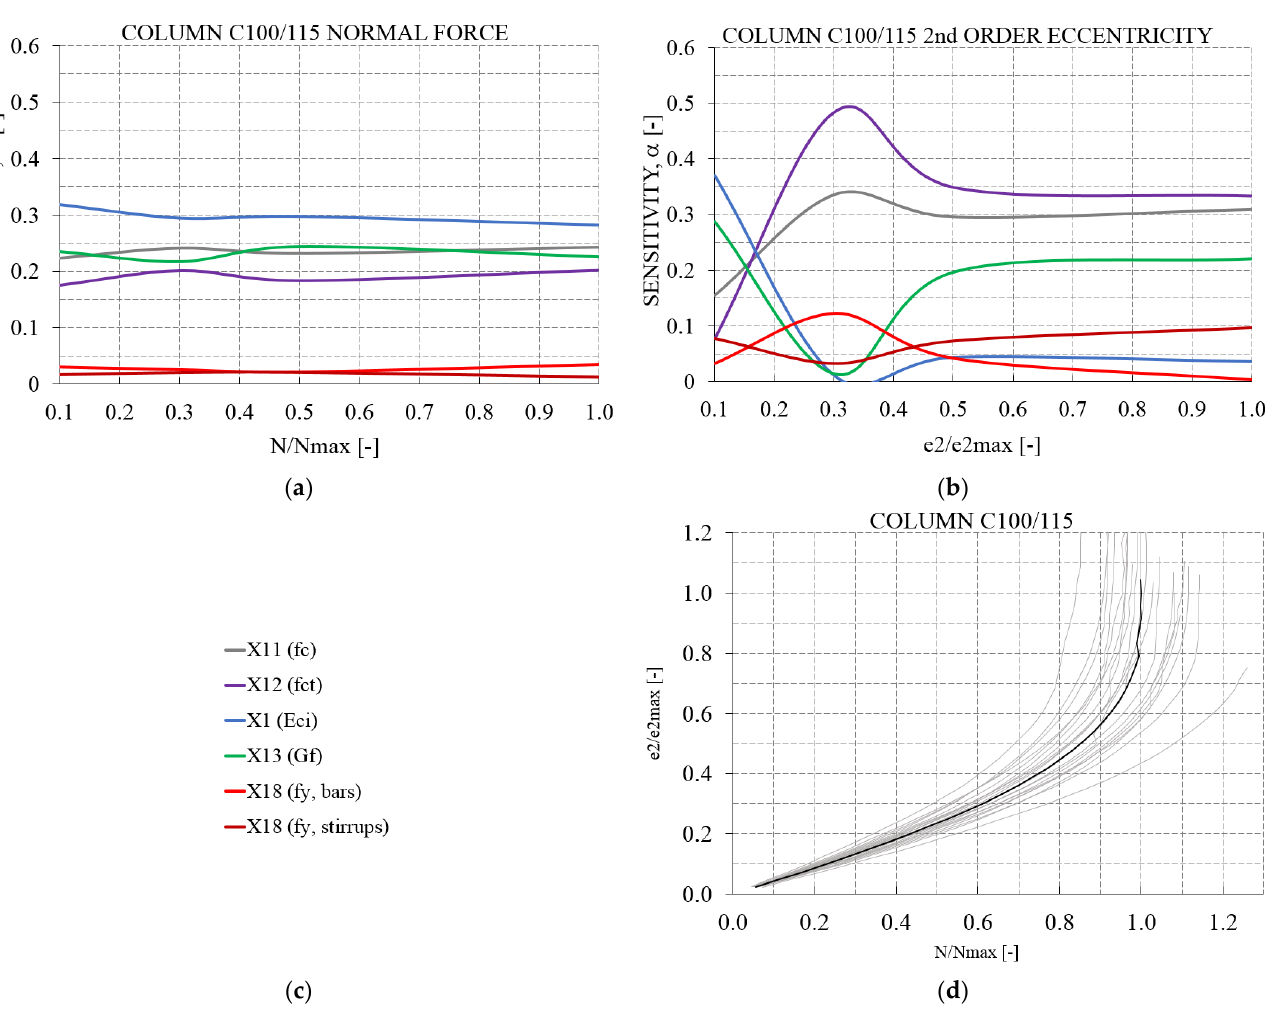
Figure 10. Sensitivity analyses at the component/column level based on the probabilistic non-linear analysis of the considered column made of C100/115, see Section 4.4: ( a ) sensitivity of material parameters with respect to the normalized applied axial force; ( b ) sensitivity of material parameters with respect to the normalized horizontal displacement at middle height of the column; ( c ) basic variables of considered material models; ( d ) normalized horizontal displacement vs. normalized axial force response.